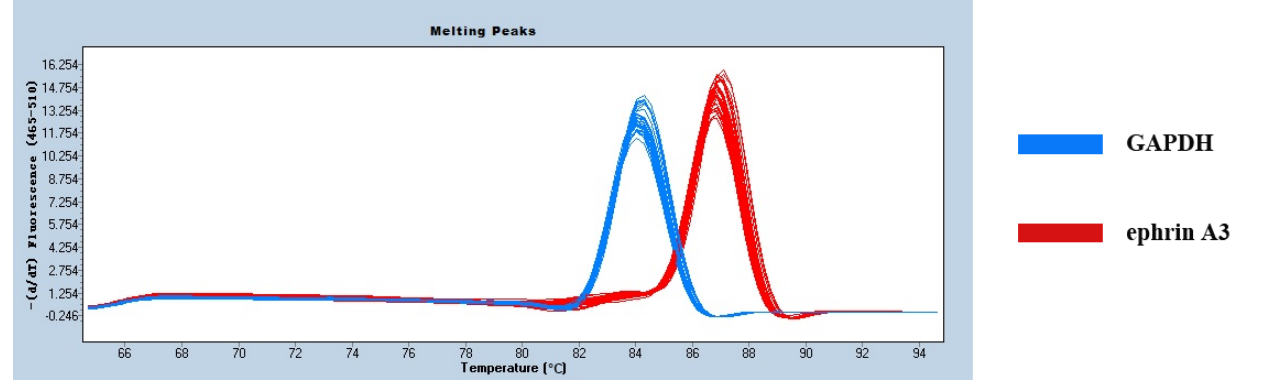
Figure 4. The melting curves of Ephrin A3 and GAPDH .